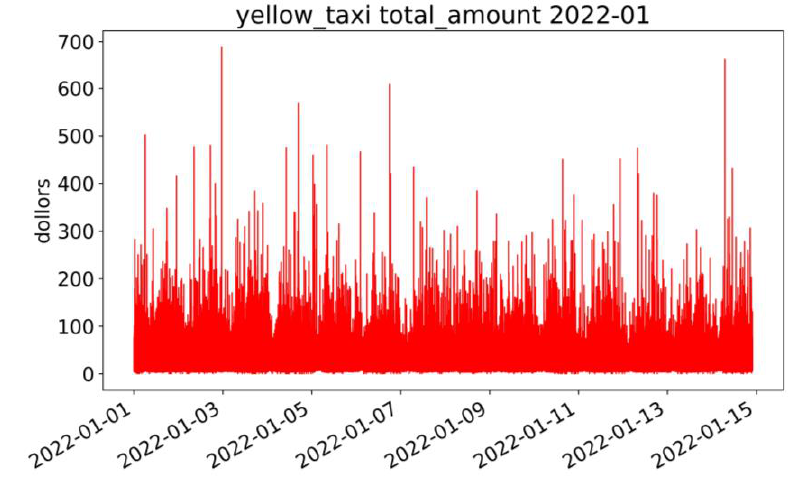
Figure 4. Revenue of yellow taxis in New York City in January.